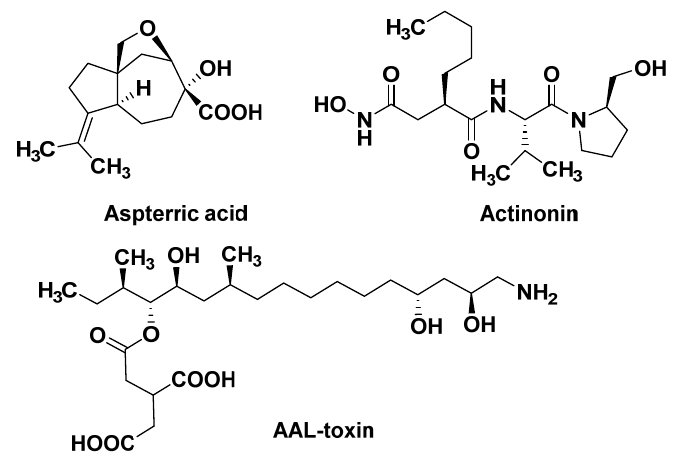
Figure 4. The structures of natural products with new